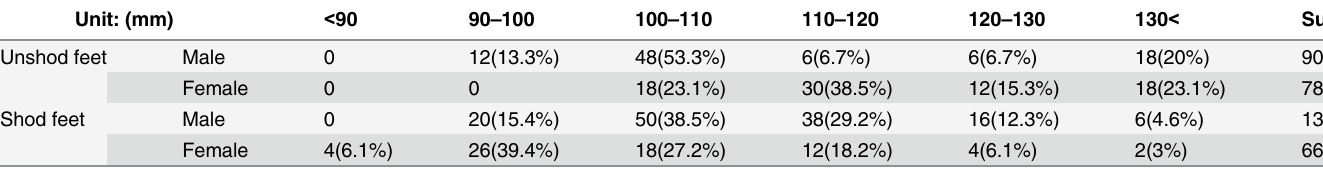
distance (Table 5) shows there is a statistically significant difference between hallux angle HA and HA ’ for both male and female runners (p = 0.001); and there is also a statistically Table 3. The width sample distribution of unshod feet and shod feet. Unit: (mm)